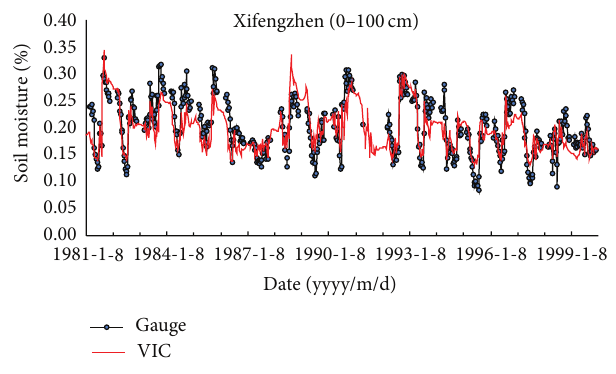
Figure 3: Comparison of simulated and observed soil moisture for depths of 0–100cm at the Xifengzhen station.